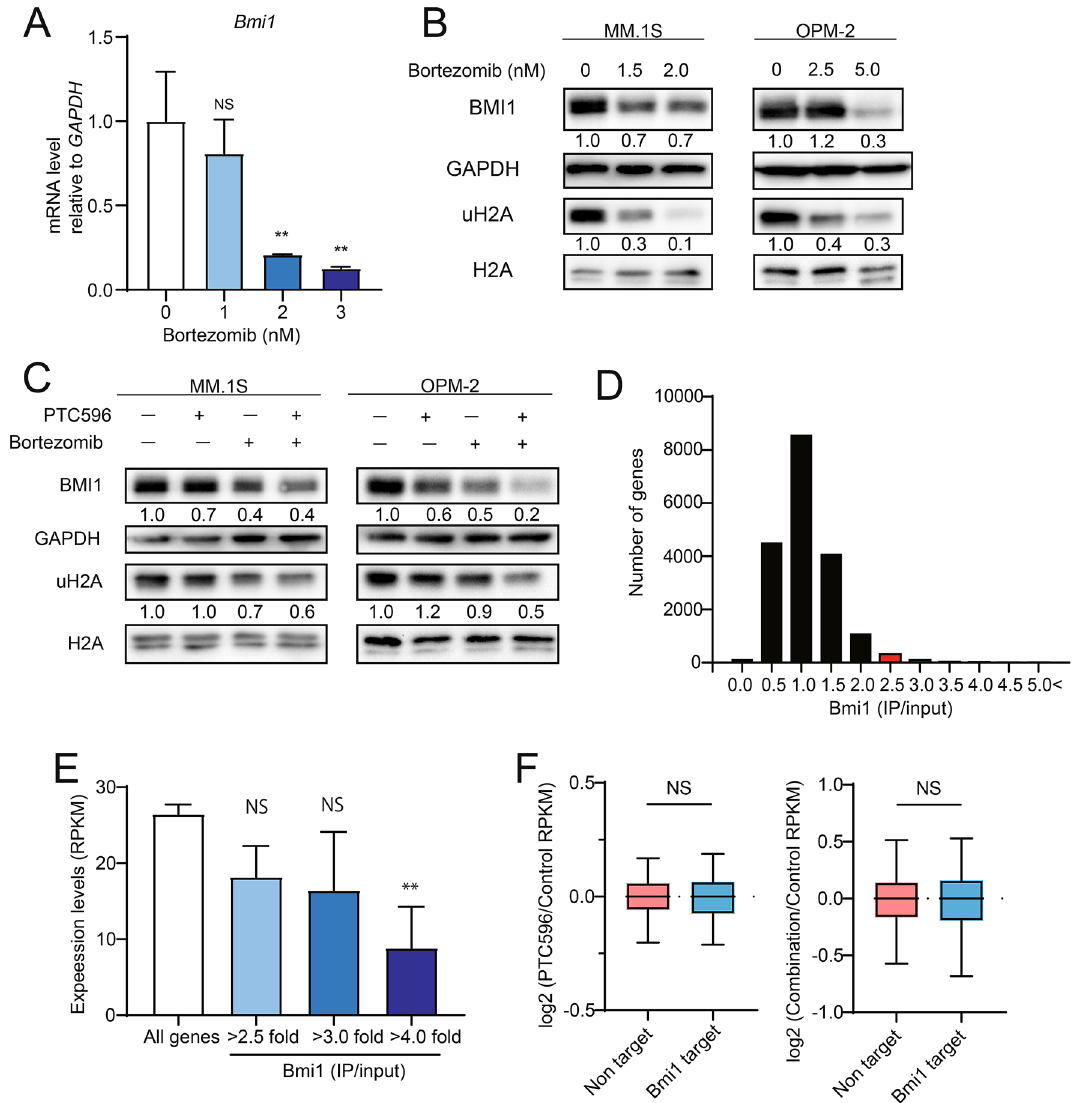
Figure 5. PTC596 does not directly target BMI1. ( A ) Quantitative RT-PCR analysis of BMI1 in MM.1S treated with the indicated dose of bortezomib for 24 h. GAPDH was used to normalize the amount of input RNA. Data are shown as the mean ± SD (n = 3). ** P < 0.01; n.s., not significant using one-way ANOVA. ( B ) Western blotting analysis of BMI1 and uH2A in MM.1S and OPM-2 upon treatment with the indicated doses of bortezomib for 48 h. GAPDH and H2A served as loading controls. ( C ) Western blotting analysis of BMI1 and uH2A in MM.1S and OPM-2 upon treatment with PTC596 (100 nM) and bortezomib (2 nM for MM.1S and 5 nM for OPM- 2) alone or in combination for 48 h. GAPDH and H2A served as loading controls. ( D ) Bmi1 targets defined by ChIP-seq data of Bmi1. Graph showing the number of genes in each range of fold enrichment values (IP/ input) of Bmi1. Genes with 2.5-fold enrichment of Bmi1 signals over the input signals in the promoter regions (transcription start sites ± 2.0 kb) were defined as direct targets of BMI1 (red bars). ( E ) Expression levels of all RefSeq genes and BMI1 target genes detected by RNA-seq (RPKM). Bmi1 target genes with fold enrichment greater than 2.5, 3.0, and 4.0 are depicted separately. ** P < 0.01; n.s., not significant using Welch’s t -test. ( F ) Box-and-whisker plots showing the expression changes of 351 BMI1 target genes in MM.1S cells treated with PTC596 alone (left panel) and PTC596 in combination with bortezomib (right panel) compared with control cells. Boxes represent 25 to 75 percentile ranges. Vertical lines represent 10 to 90 percentile ranges. Horizontal bars represent median. ns not significant using Student’s t